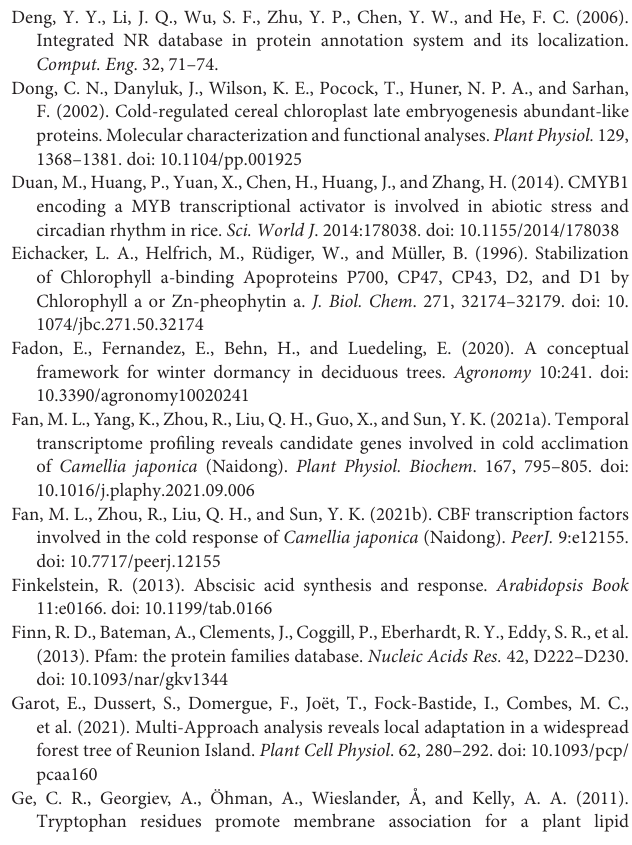
Supplementary Figure 3 | Expression of candidate genes in response to cold stress as determined by RT-qPCR (A) and the transcriptome (B) . Supplementary Table 1 | The raw data of physiology index. Supplementary Table 2 | The sequence data of transcriptomics and proteomics. Supplementary Table 3 | The enrichment KEGG pathways of Tg vs. Sg. Supplementary Table 4 | The enrichment GO terms of Tg vs. Sg. Supplementary Table 5 | The functional enrichment pathways of Tg and Sg under cold stress. Supplementary Table 6 | The functional enrichment pathways of Tg vs. Sg under cold stress. Supplementary Table 7 | The enrichment GO terms of WGCNA. Supplementary Table 8 | The enrichment KEGG pathways of WGCNA. Supplementary Table 9 | The annotation of cold genes related to photosynthesis. Supplementary Table 10 | The annotation of Carbon fixation. Supplementary Table 11 | The annotation of ribosome. Supplementary Table 12 | The raw data of plant hormone measurement. Supplementary Table 13 | The temperature of Qingdao and Zhoushan. Supplementary Table 14 | The primer and RAW data of